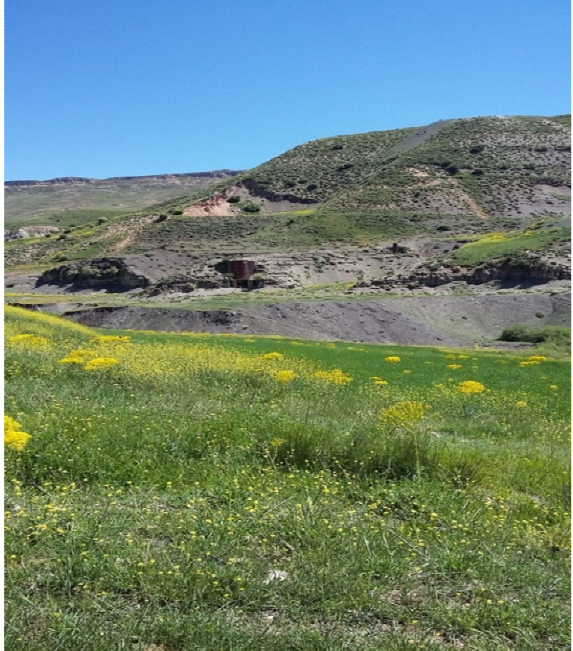
Figure 2. Location of oil shale at Timahdit.